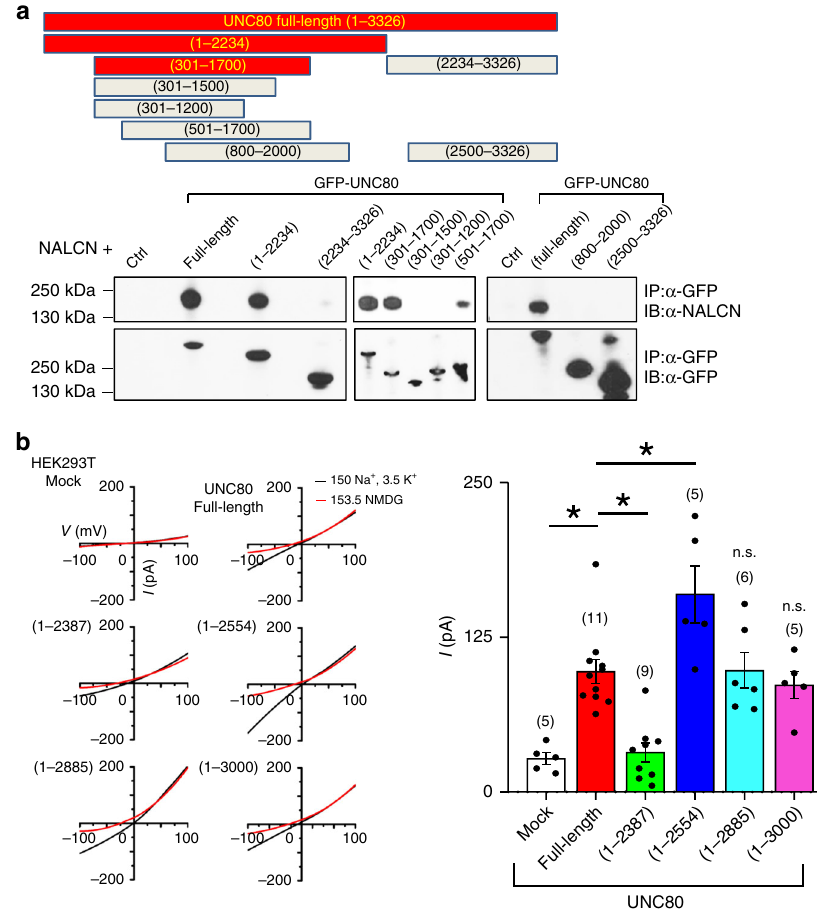
Fig. 5 UNC80 ’ s N-terminal half interacts with NALCN. a Co-immunoprecipitation assays to locate fragments on UNC80 required for its association with NALCN. Upper panels, schematic presentation of mouse UNC80 truncation mutants used in the studies. Lower panels, HEK293T cells were co-transfected with NALCN and GFP-tagged full-length or truncated UNC80 containing residues as indicated. Cell lysates were immunoprecipitated (IP) with anti-GFP followed by immunoblotting with anti-GFP (lower) or anti-NALCN (top). GFP was used in “ ctrl ” . It migrated at ~20 kDa (outside the molecular ranges shown) and is not visible in the blots. More than three independent repeats were performed with similar results. b I NALCN from cells transfected with NALCN and wild-type or truncated UNC80 mutants as indicated. Recordings were done using a ramp protocol from − 100 to + 100 mV in 1 s (holding voltage V h = 0 mV). To ensure that the current was not from nonspeci fi c leak, bath cations were replaced with large non-permeant ion NMDG after each recording (see “ Methods ” for details). Bar graphs show averaged I NALCN amplitude (at − 100 mV). Two sample t test of each group against the “ full-length ” group ( n = 11) was performed and the p values are: “ Mock ” ( n = 5, p ≤ 0.001), “ 1 – 2387 ” ( n = 9, p ≤ 0.001), “ 1 – 2554 ” ( n = 5, p = 0.019), “ 1 – 2885 ” ( n = 6, p = 0.818), “ 1 – 3000 ” ( n = 5, p = 0.933). Asterisk “ * ” indicates p < 0.05. Data are presented as mean values± SEM. Numbers of cells are in parentheses. Source data are provided as a Source Data fi